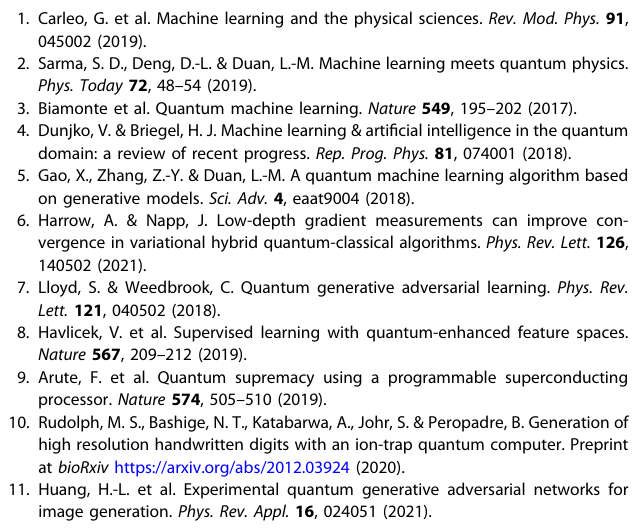
Fig. 3 QGAN performance in learning the XOR gate. a Tracking of the loss function V , the averaged output scores S D averaged state fi delity between R/G ’ s output states F during the adversarial training process with learning rates α D = 1.0 and α G = 1.5. The blue dashed line denotes the training fi delity of 0.9. The maximum step number is limited to 50 for both G and D. S D F are averaged over four possible inputs. Inset: The truth table of G after training in comparison with that of the XOR gate. b Trajectories of two representative parameters constructing D and G, θ x θ x , during the QGAN training. All parameters in G and D are 3 ; 1 ; G initialized randomly between 0 and π and optimized alternately during the truth table close to that of an XOR gate, as shown in the inset of Fig. 3a. Note that the fi delity of trained XOR gate is lower than the fi delity of the above mentioned single qubit mixed state. Due to the complexity of learning task, generator consisting of more layers and parameters is employed for training XOR gate, which would introduce more two-qubit gate in fi delities and decoher- ence error during the learning.